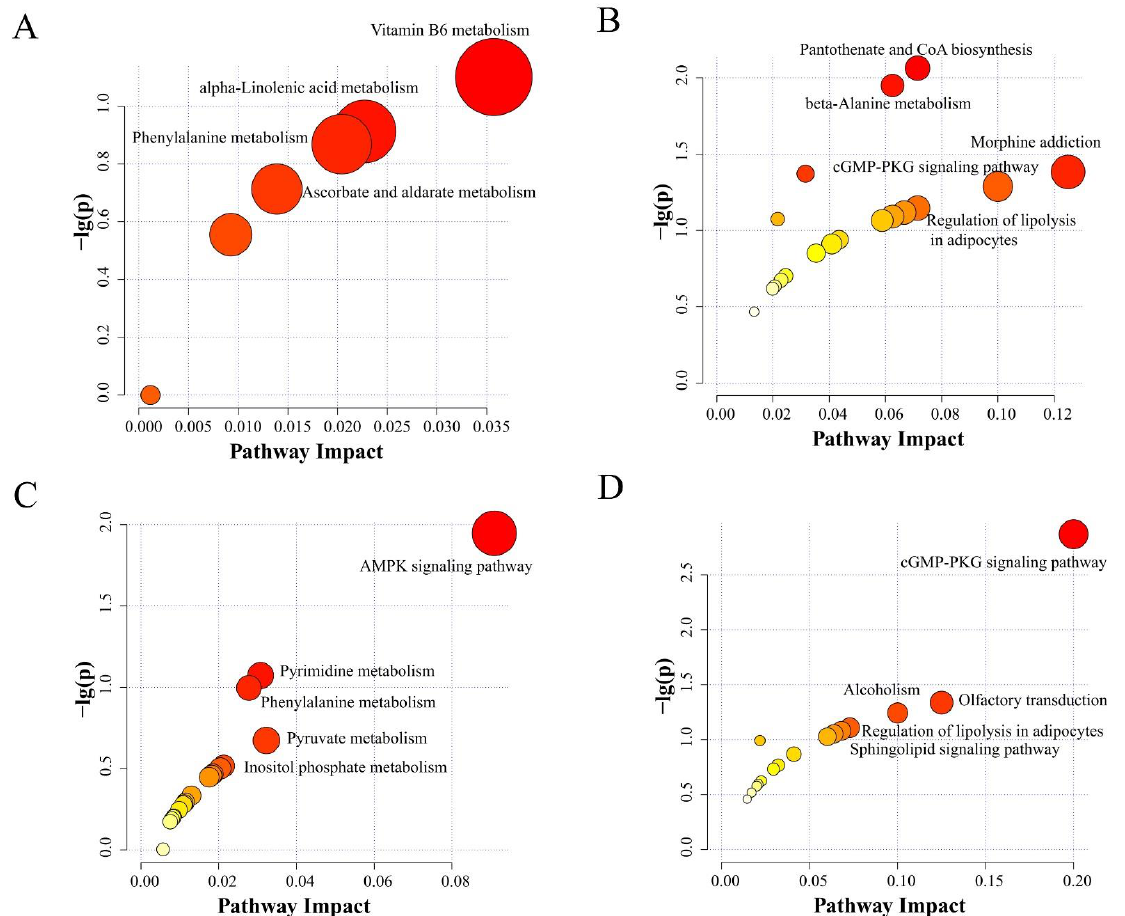
Figure 5. Milk KEGG pathway analysis of differential metabolites in the pairwise comparisons of LCaP compared to CON ( A ), MCaP compared to CON ( B ), HCaP compared to CON ( C ), and MCaP compared to HCaP ( D ). The x-axis is the pathway impact and the y-axis is the value of − log ( p ). The larger size indicates higher pathway enrichment and the darker color indicates higher pathway impact values. CON: control group, without calcium propionate addition; LCaP: low calcium propionate, the calcium propionate addition level was 200 g/d per cow; MCaP: medium calcium propionate, the calcium propionate addition level was 350 g/d per cow; HCaP: high calcium propionate, the calcium propionate addition level was 500 g/d per cow.